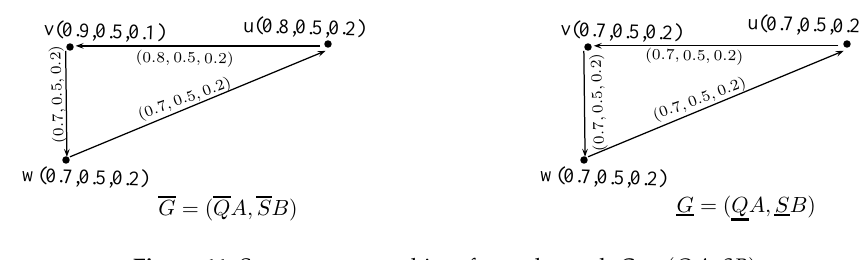
Figure 11: Strong neutrosophic soft rough graph G = ( QA, SB ) Figure 11. Strong neutrosophic soft rough graph G “ p QA , SB